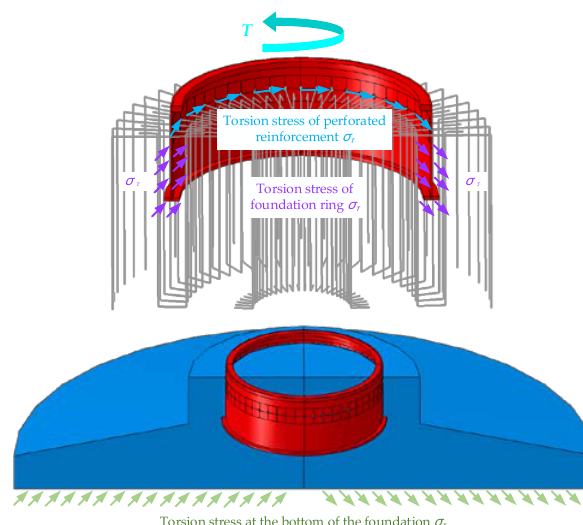
Figure 2. Torque load transfer process within the foundation.